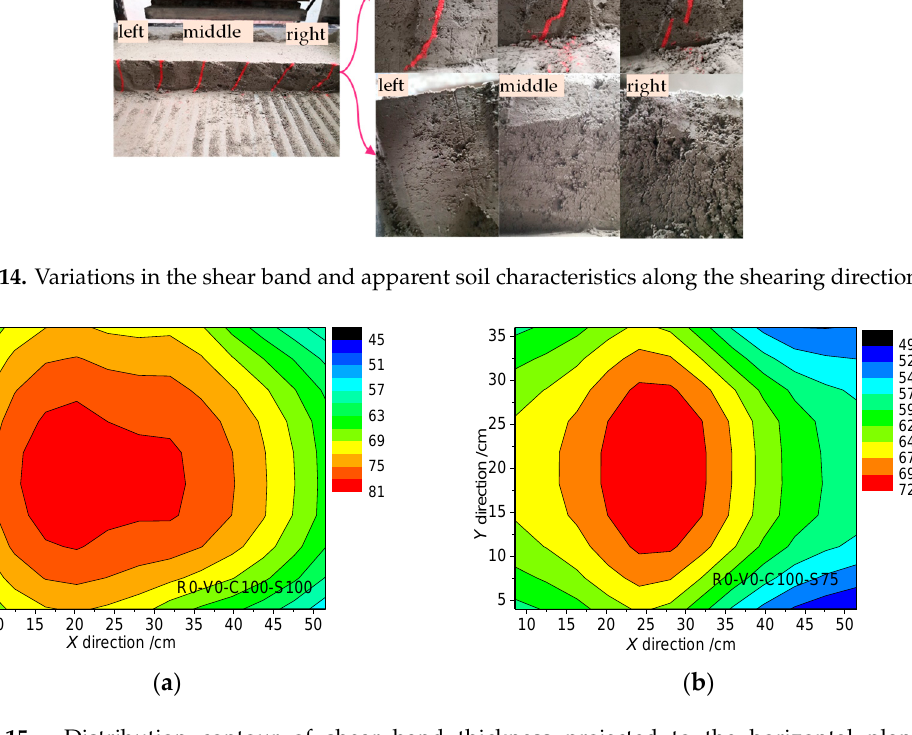
Figure 15. Distribution contour of shear band thickness projected to the horizontal plane: ( a ) R0-V0-C100-S100; ( b ) R0-V0-C100-S75.